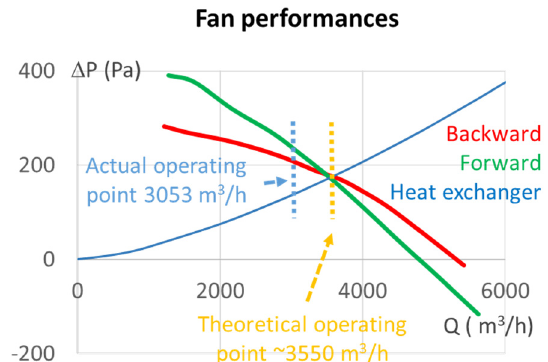
Figure 6. Fan performances compared to the radiator resistance.